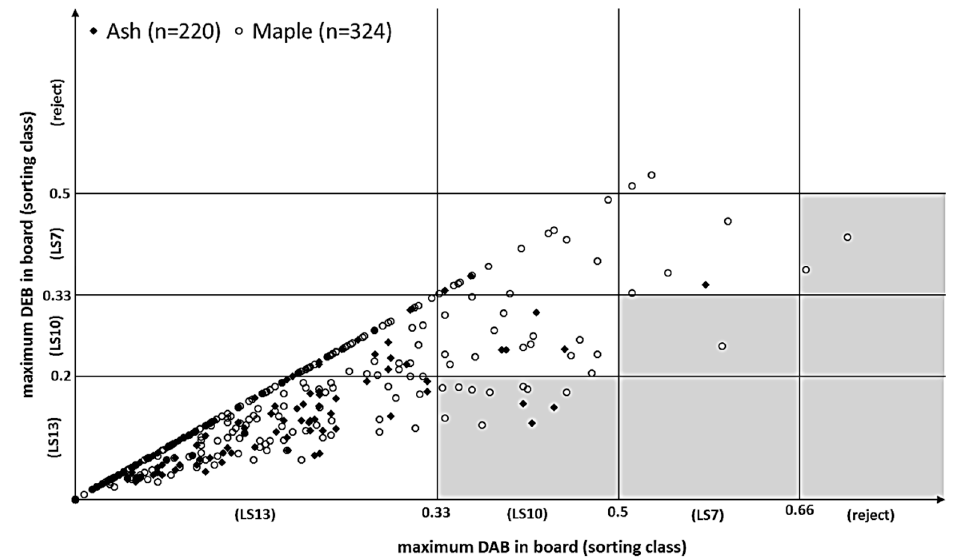
Figure 5. Maximum knot ratio of single knot (DEB) and knot cluster (DAB) for ash and maple boards. For all boards in grey area the criterion knot cluster (DAB) leads to downgrading into lower sorting class.